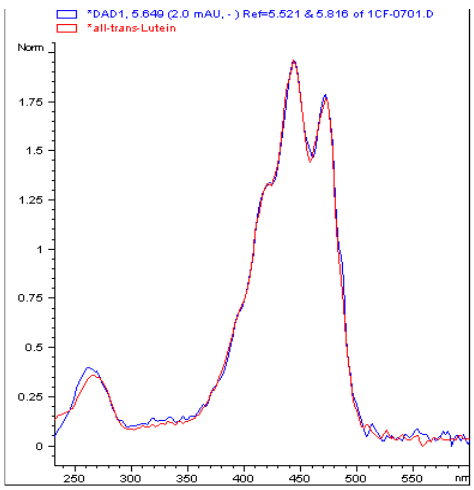
Figure 2. The spectrum of a peak found in a serum sample at retention time of 5.649 is matched against the library, which contains the spectra obtained from carotenoid standards. The peak is identified as all- trans -lutein with a matching score of 993.402 and a purity factor of